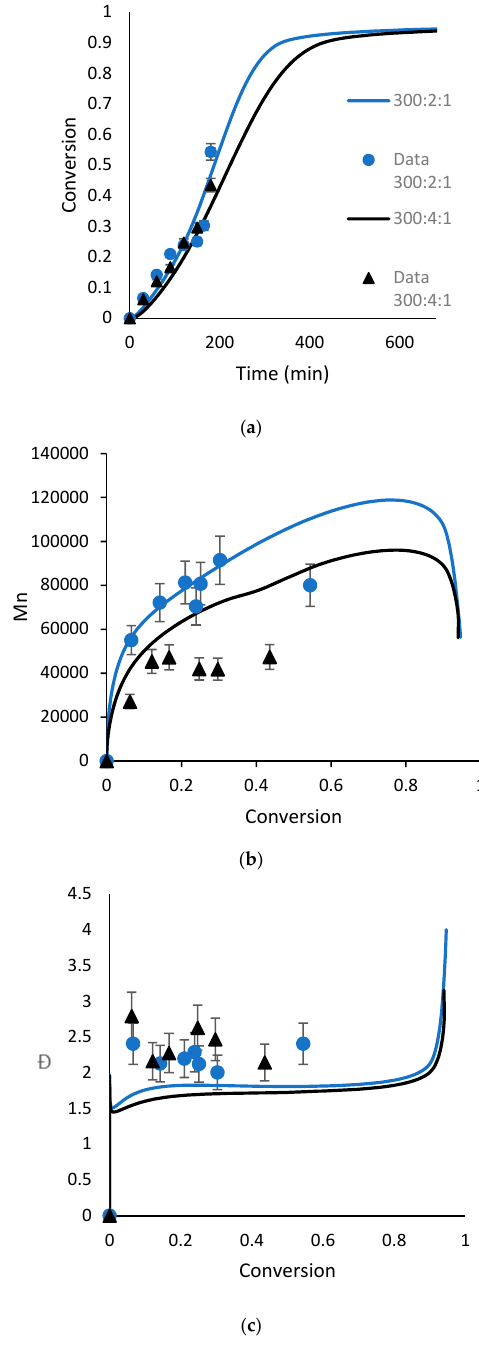
Figure 7. Comparison of model predictions and experimental data of ( a ) monomer conversion versus time, ( b ) number average molar mass versus conversion, and ( c ) Ð versus conversion. [methyl methacrylate (MMA)]:[ γ -phenyl- γ -butyrodithiolactone (DTL1)]:[2,2-azobisisobutyronitrile (AIBN)] = 300:2:1 for EXP 1 and 300:4:1 for EXP